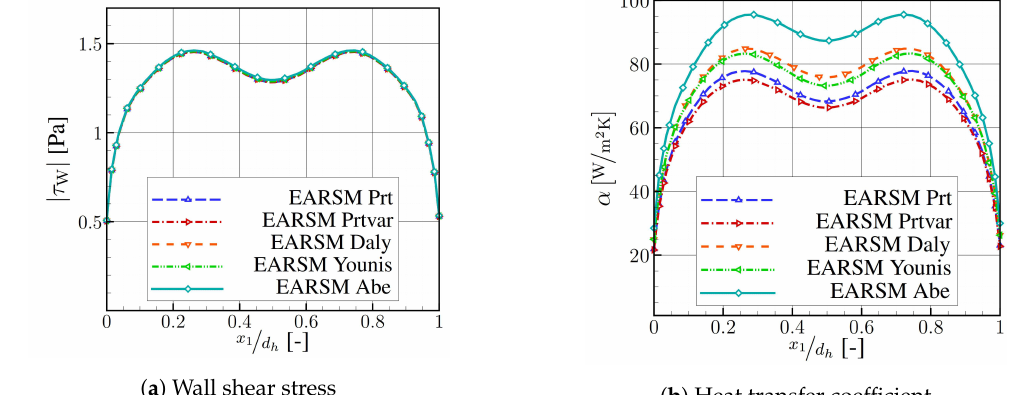
Figure 4. Values over normalized channel width along the wall at x 3 = 14 d h